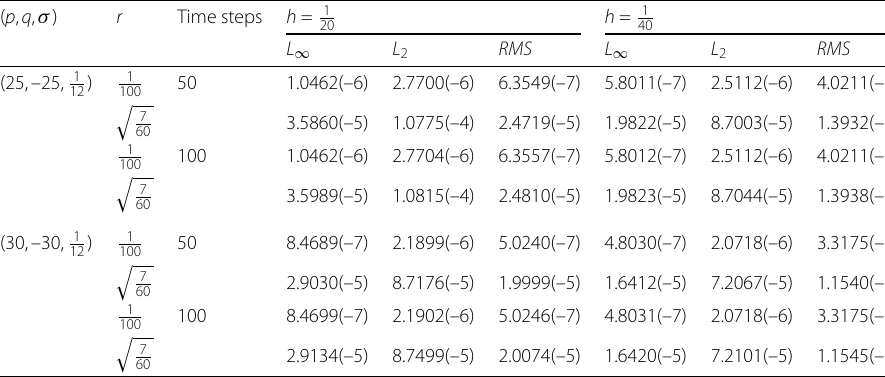
Table 1 L ∞ , L 2 and RMS errors for Example